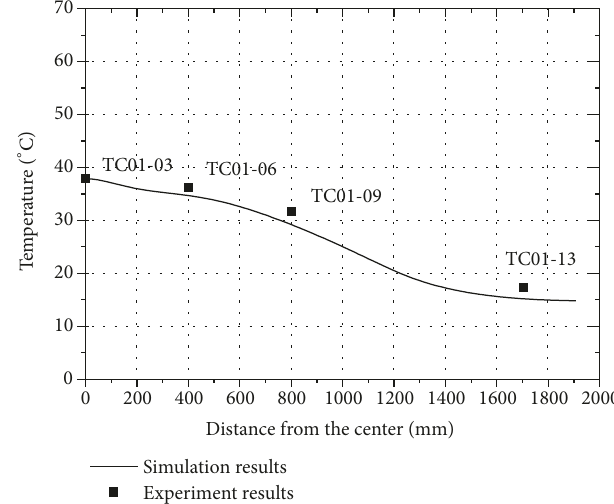
Figure 12: The temperature contrast of simulation and experiment at the support bottom in Test B1.